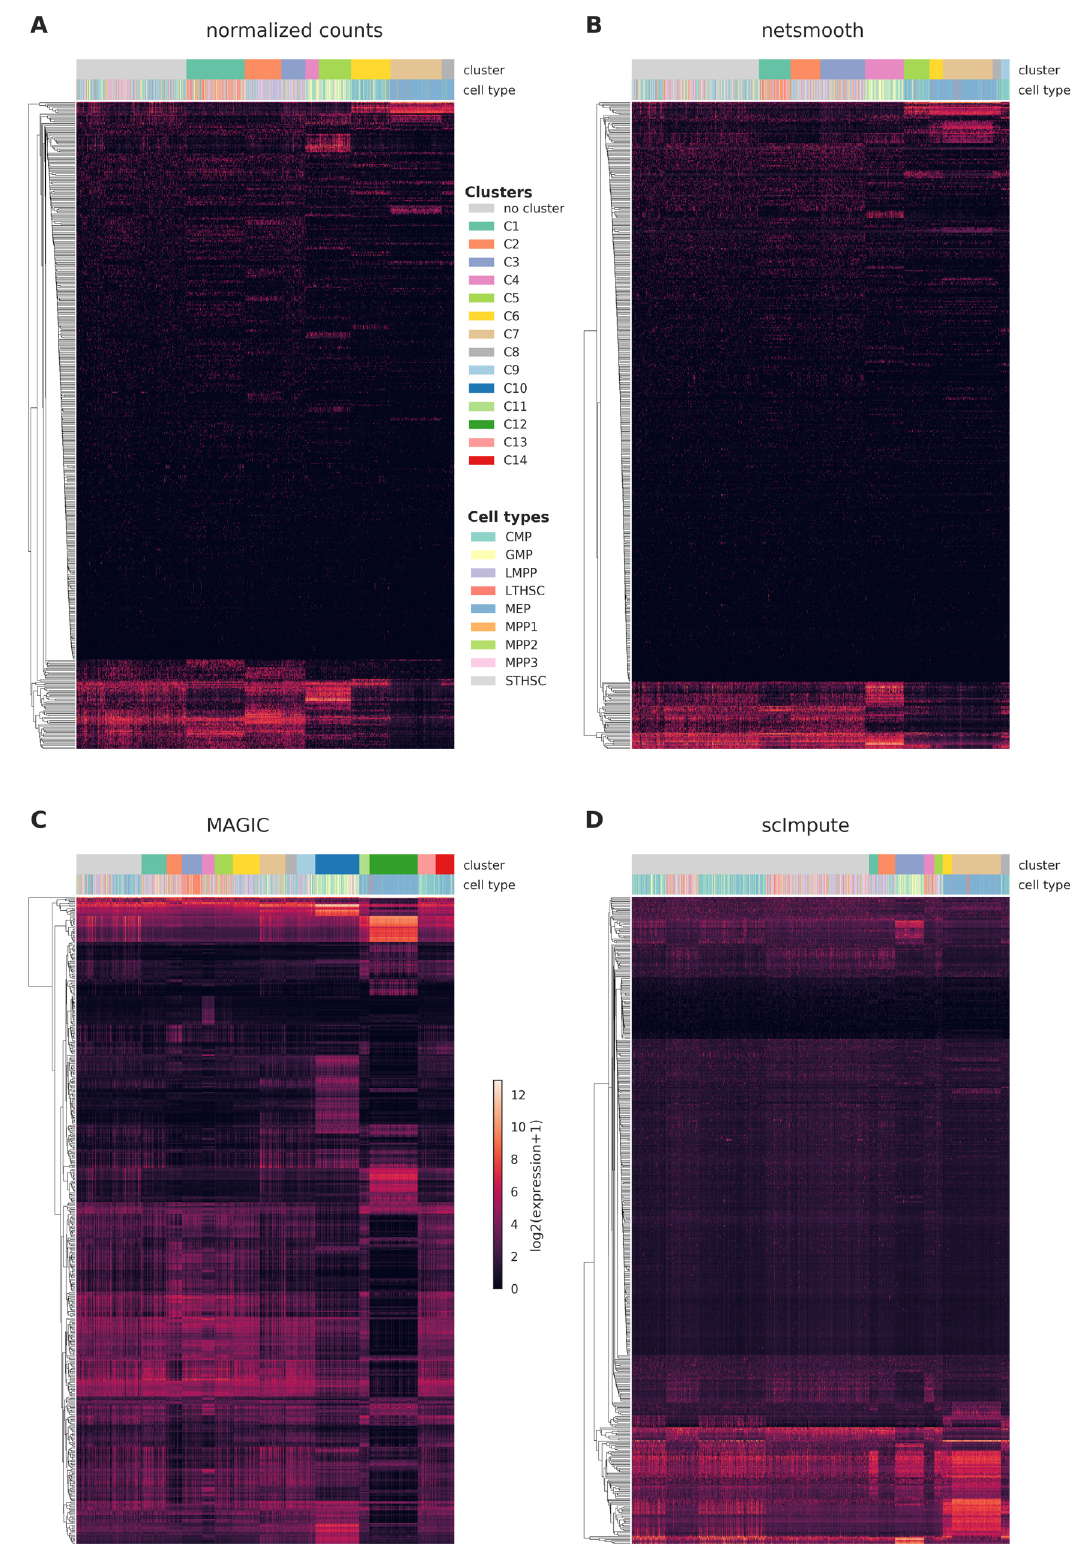
Figure 2. Cells were clustered using the robust clustering procedure, and the log-transformed expression values of the log-transformed expression values of the 500 most differentially expressed genes (by edgeR-QLF test adjusted P value) in any of the discovered clusters are shown in a heatmap, as well as cluster assignments and FACS-sorted cell types. A ) raw (no imputation), B ) after application of netSmooth , C ) missing values imputed using MAGIC D ) missing values imputed using